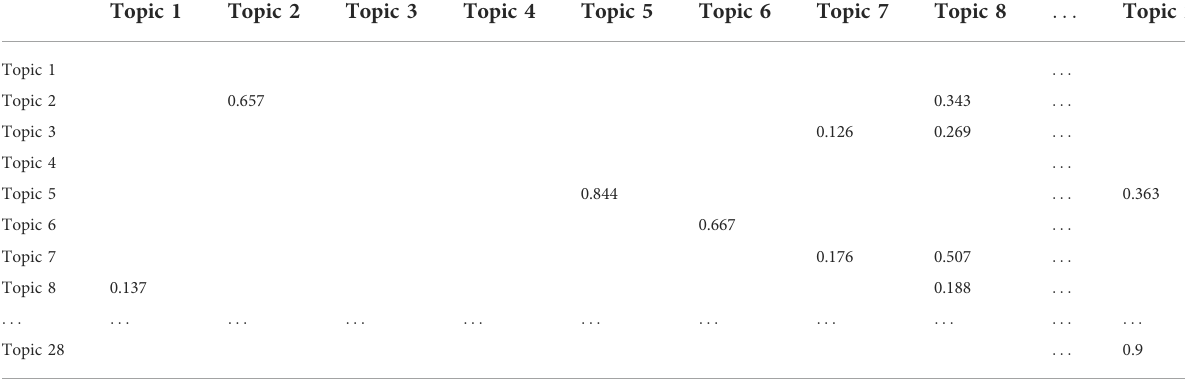
TABLE 6 Matrix of optimal transfer relations between